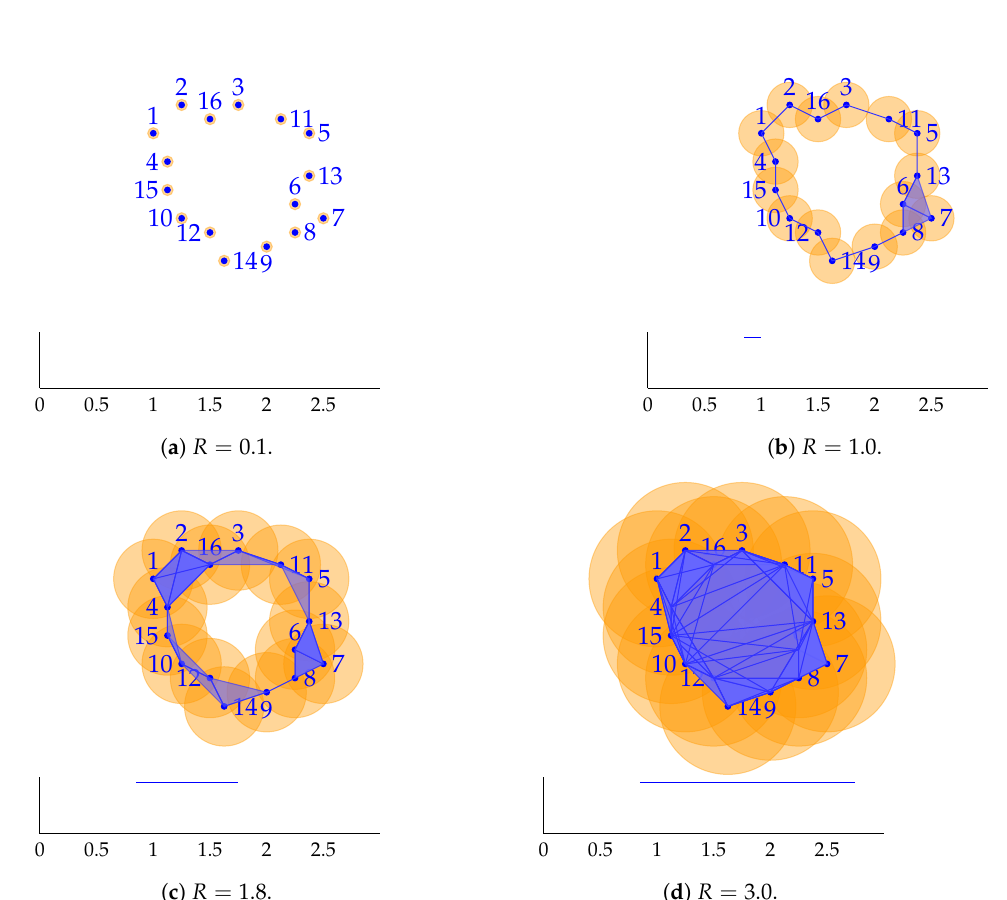
Figure 2. Interpretation of TDA. Orange circles have diameter R , the topology parameter. Below each simplicial complex, the bar code corresponding to dimension 1 holes) is represented. ( a ) For a sufficiently small R parameter, say, 0.1, only a collection of data points is visible, with no topology at dimension 1. ( b ) Increasing R to 1.0 makes the first circular topology appear. This hole is visible for R > 0.8, hence the bar in the diagram from R = 0.8 to R = 1.0. ( c ) If we increase R , no perceptible changes are observed. Only one hole persists and it is reflected in the bar code below. ( d ) The hole disappears by formation of big triangles at about R = 2.8. From the observation of the bar code, we notice that the data set has the topology of a circle, with one single interior hole. In general, those holes or voids that persist the most reflect the persistent topology of the